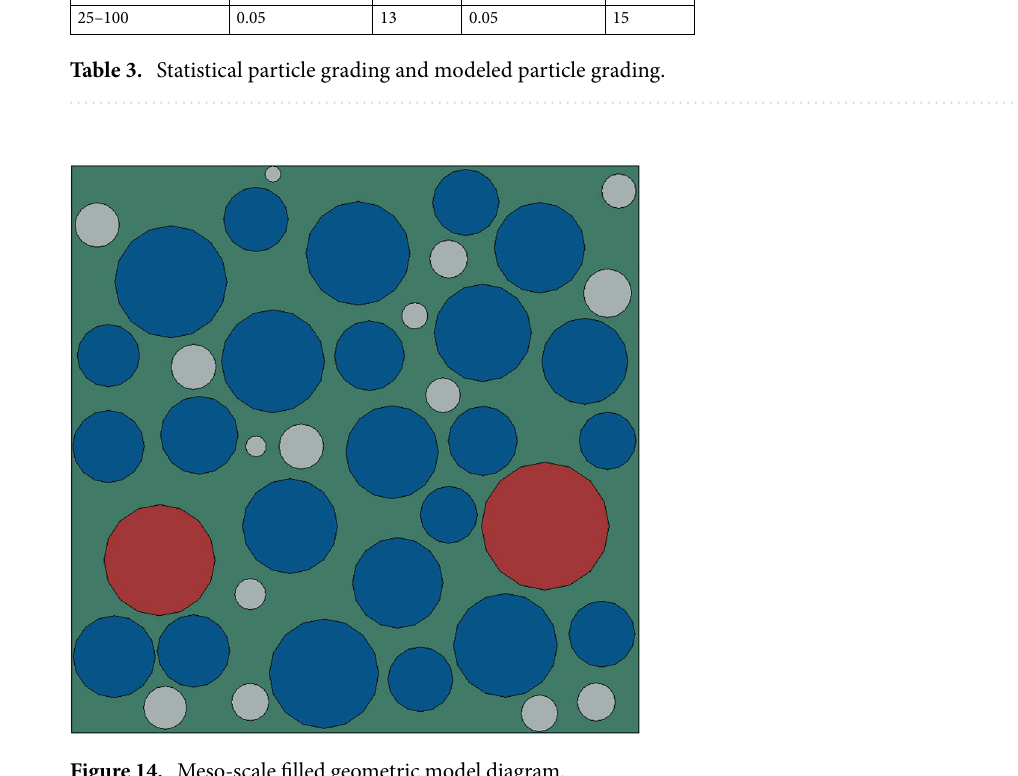
Figure 14. Meso-scale filled geometric model diagram.